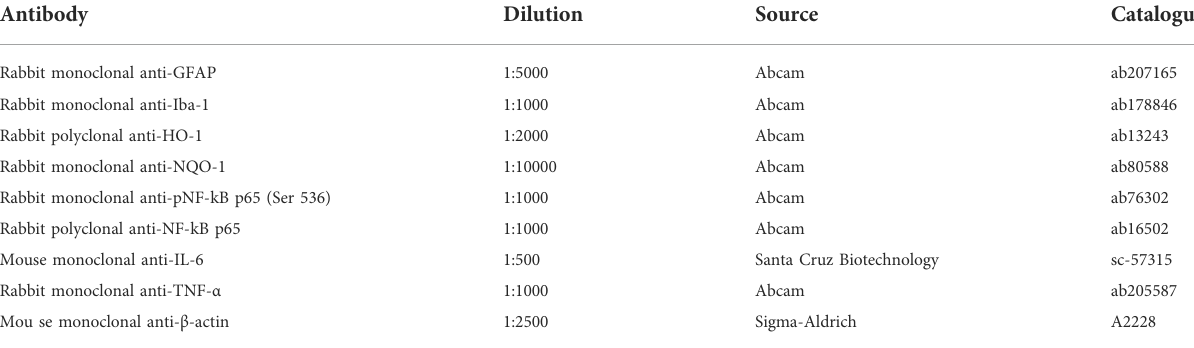
TABLE 1 Western Blot primary